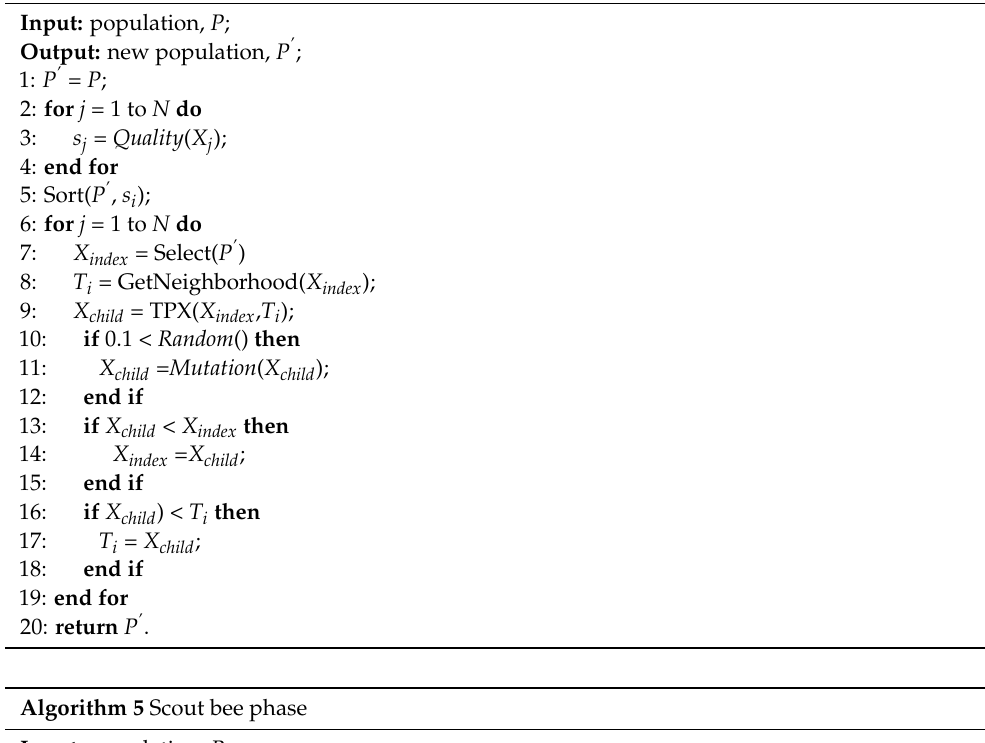
Algorithm 4 Onlooker bee